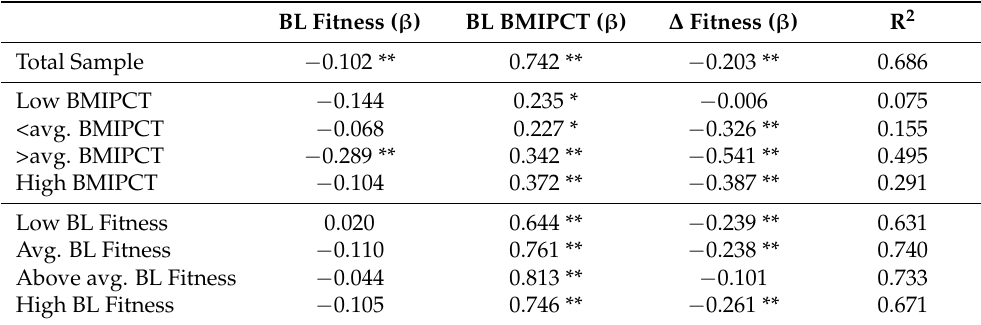
Table 4. Regression coefficients based on linear regression analysis for overall BMI percentile at last